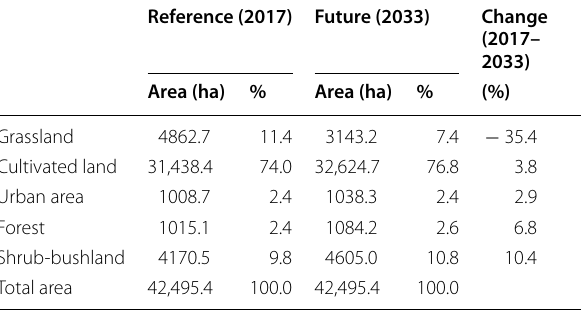
Table 7 Area and proportion of each land use categories in the Muga